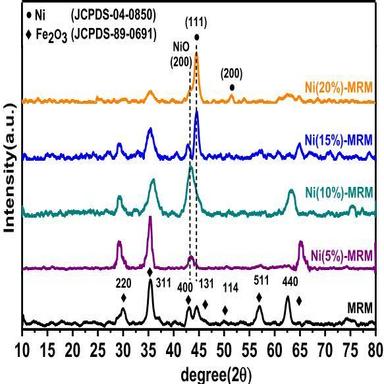
X-Ray diffraction patterns of Ni-MRM materials with Ni loading of 5 %, 10 %, 15 % and 20 %.